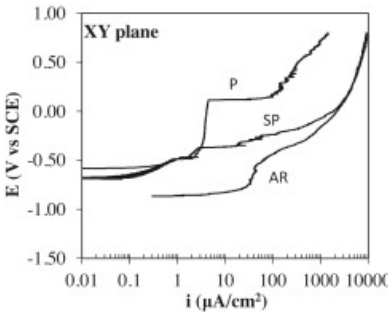
Figure 7. Polarization curves of printed AlSi10Mg alloy in diluted Harrison’s solution on XY specimens with different surface treatment [91].